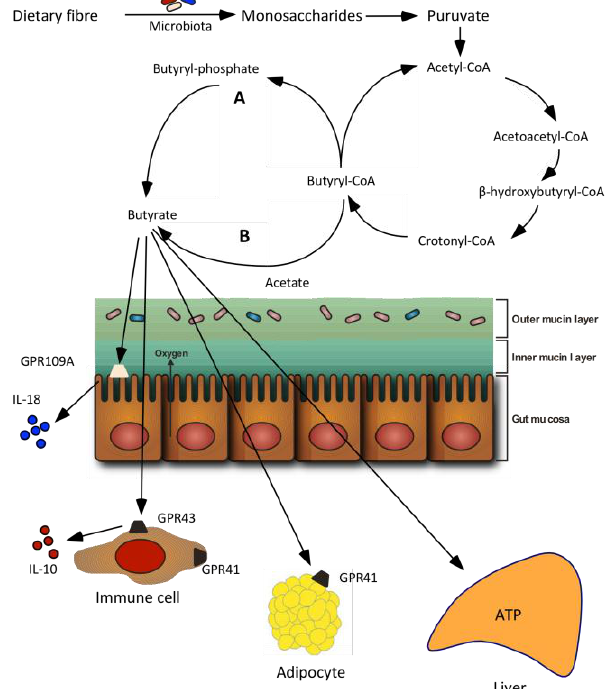
Figure 1. Butyrate formation from dietary fibre and absorption in the large intestine. Two pathways of butyrate production from butyryl-CoA in bacteria has been reported. Letter “A” indicates that butyryl-CoA is phosphorylated to butyryl-phosphate and converted to butyrate via butyrate kinase. Letter “B” shows that the CoA moiety of butyryl-CoA is transferred to external acetate via butyryl-CoA: acetate transferase, leading to the formation of butyrate and acetyl-CoA [38]. Several receptors for butyrate including G-protein-coupled receptors 41 (GPR41), GPR43 and GPR109A have been identified. GPR41 is found in adipose tissues and immune cells, GPR43 in immune cells whereas GPR109A is present in colonic cells. GPR109A is essential for butyrate-mediated induction of IL-18 in colonic epithelium. Modified from [27].